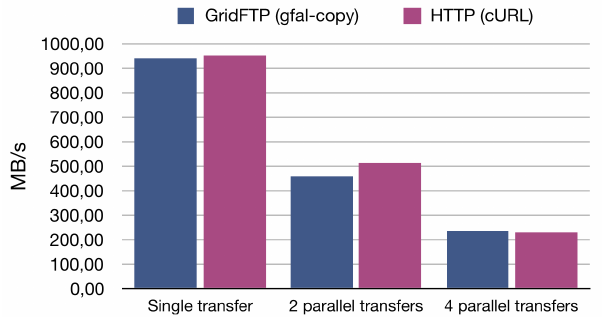
Figure 5. The average transfer rate observed using curl as a client for plain HTTP transfers against the rate observed using gfal-copy for GridFTP